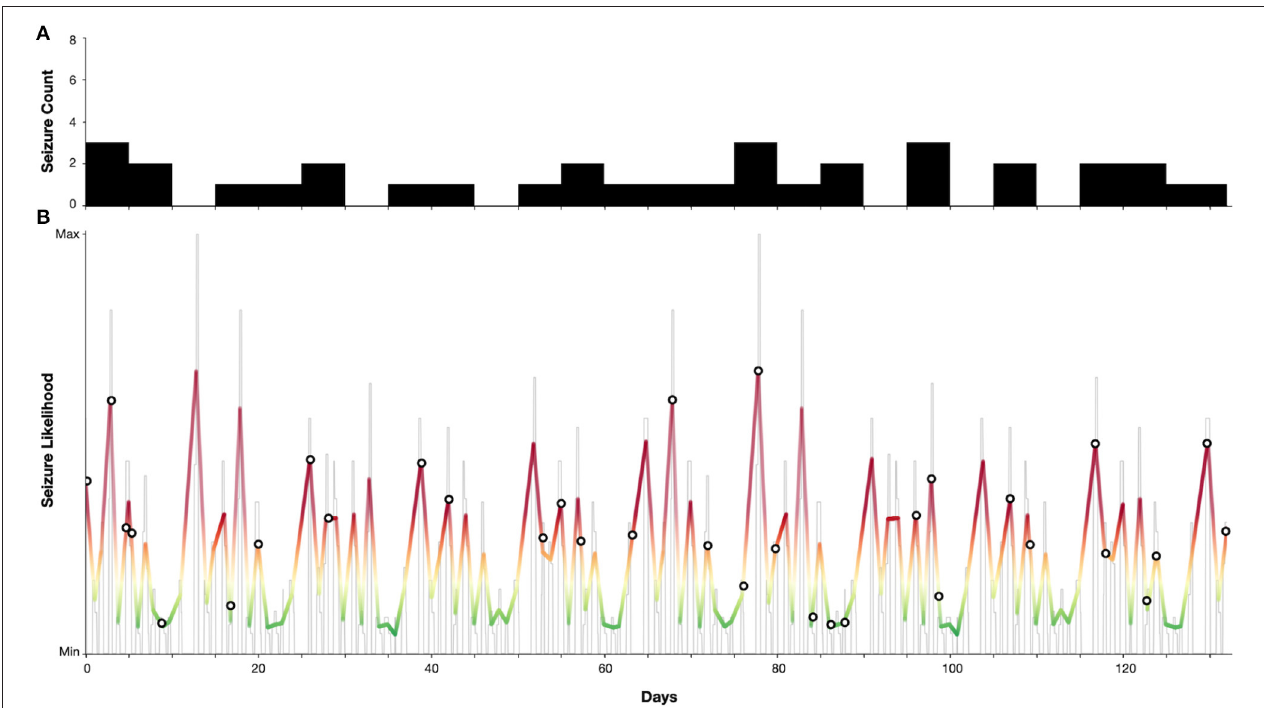
FIGURE 4 | Case study of an individual with juvenile absence epilepsy with 5 and 13-day seizure cycles. (A) Self-reported seizure counts (bin-width of 5 days). (B) Estimated seizure likelihood (grey—raw likelihood estimate, colour—smoothed likelihood). Markers indicate self-reported seizure occurrences. Note that the majority (79%) of seizures occurred when the seizure likelihood was